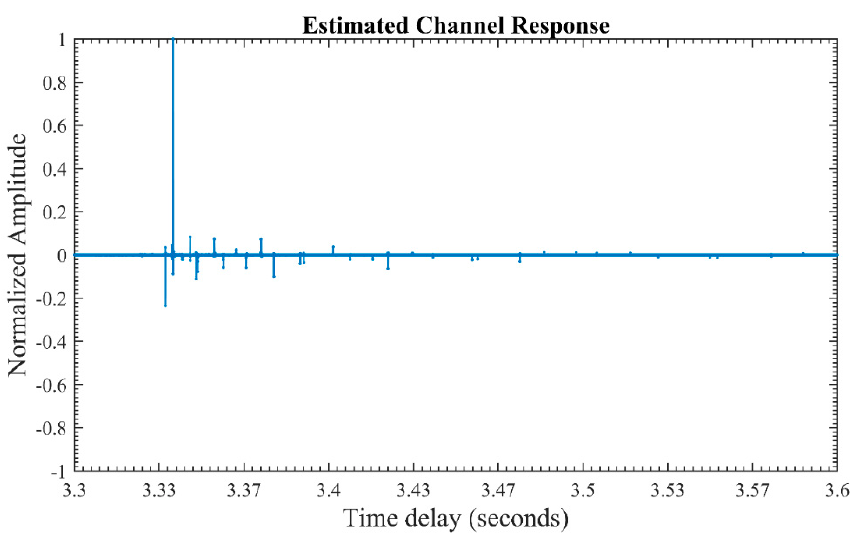
Figure 15. MP Estimated Channel Impulse Response.